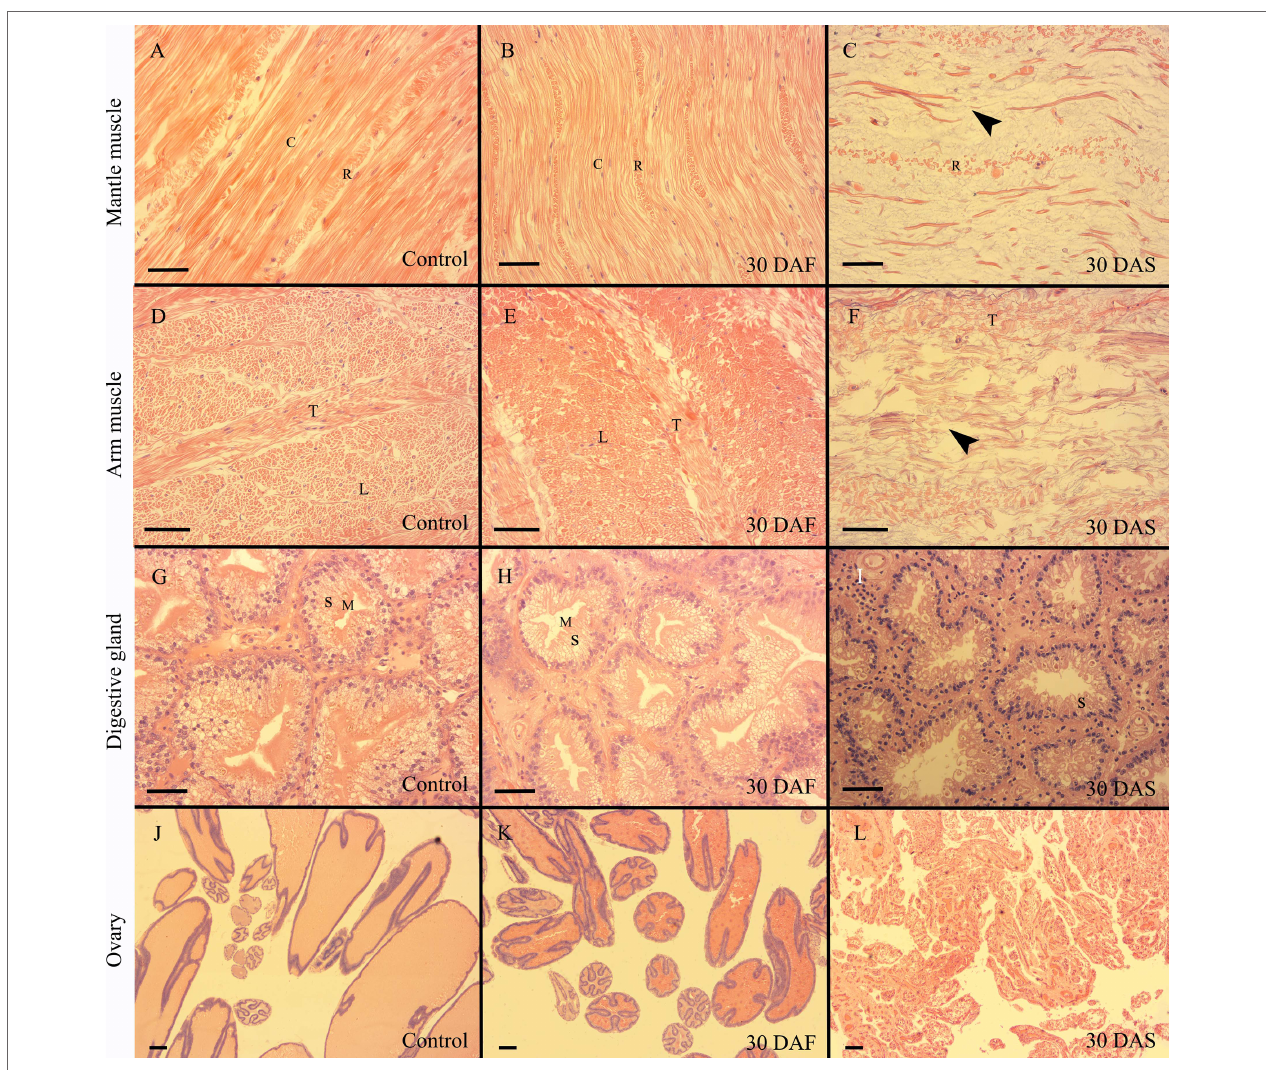
FIGURE 2 | Histology of O.sinensis mantle muscle, arm muscle, digestive gland and ovary. (A–C) Longitudinal sections of mantle muscle. (D, E) Transverse sections of arm muscle. (F) Longitudinal section of arm muscle. (G–I) Digestive gland. (J–L) Ovary. Black arrow heads indicate the broken circular muscle fibers. C, circular muscle fiber; DAF, days after fasting; DAS, days after spawning; L, longitudinal muscle fiber; M, microvilli; R, radial muscle fiber; S, secretory cell; T, trabeculae; Scale bar (A–I) :50 μm. Scale bar (J–L) :100